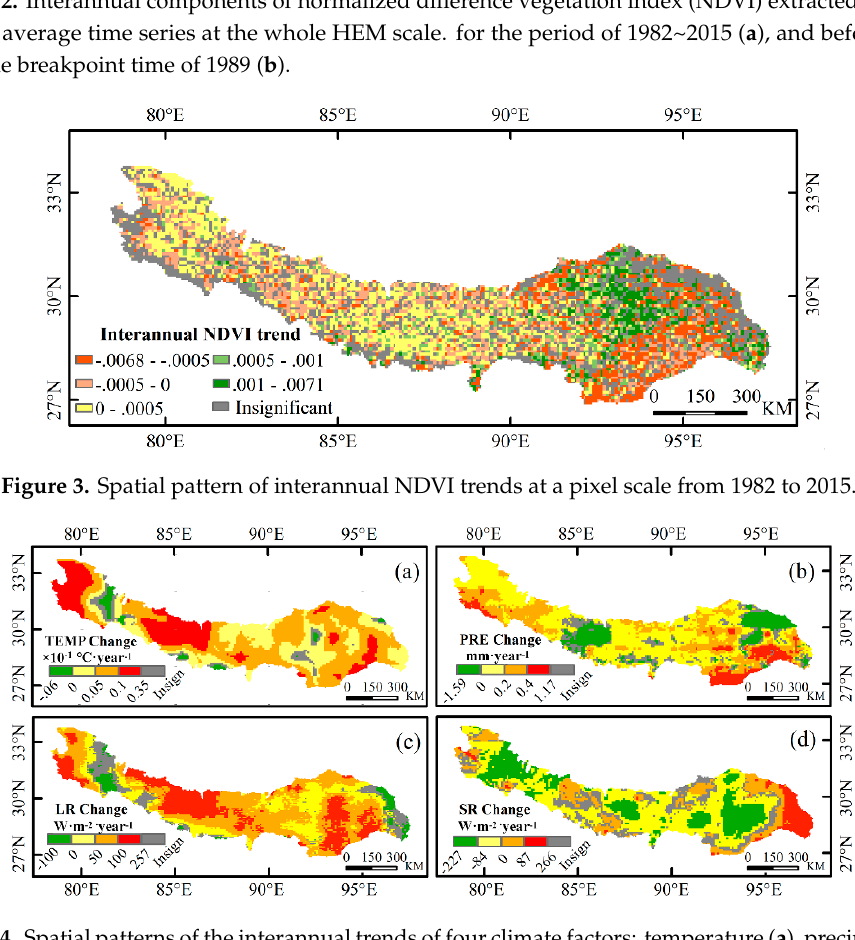
Figure 4. Spatial patterns of the interannual trends of four climate factors: temperature ( a ), precipitation ( b ), downward long-wave radiation ( c ), and downward short-wave radiation ( d ).